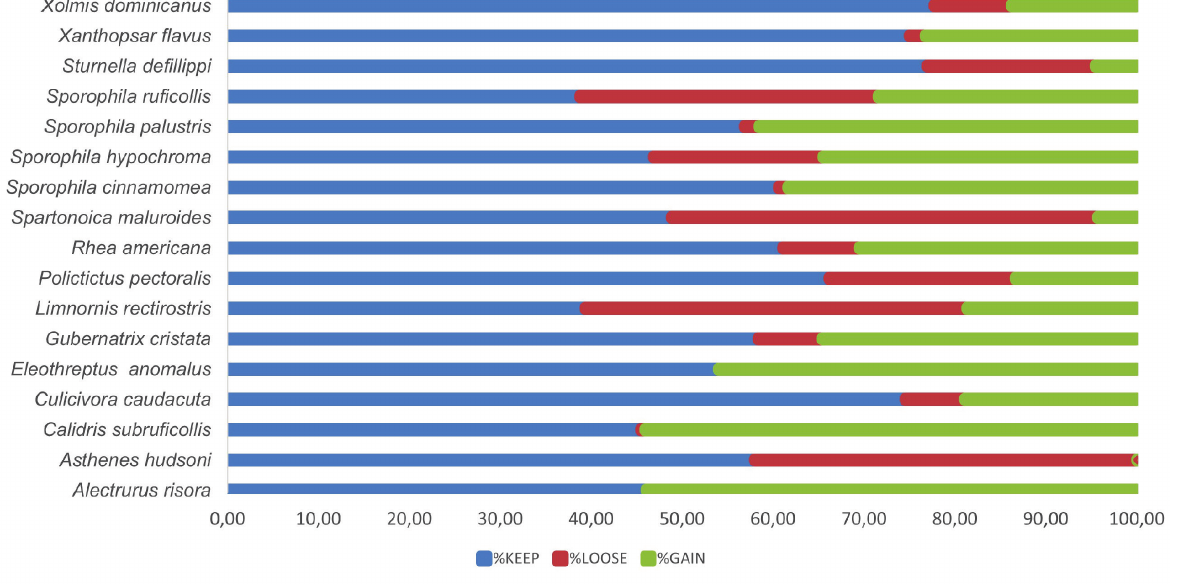
Figure 2. Bar plot showing the average percentage of environmental suitability that each species wins, lose, and keep between current predictions and the average of future